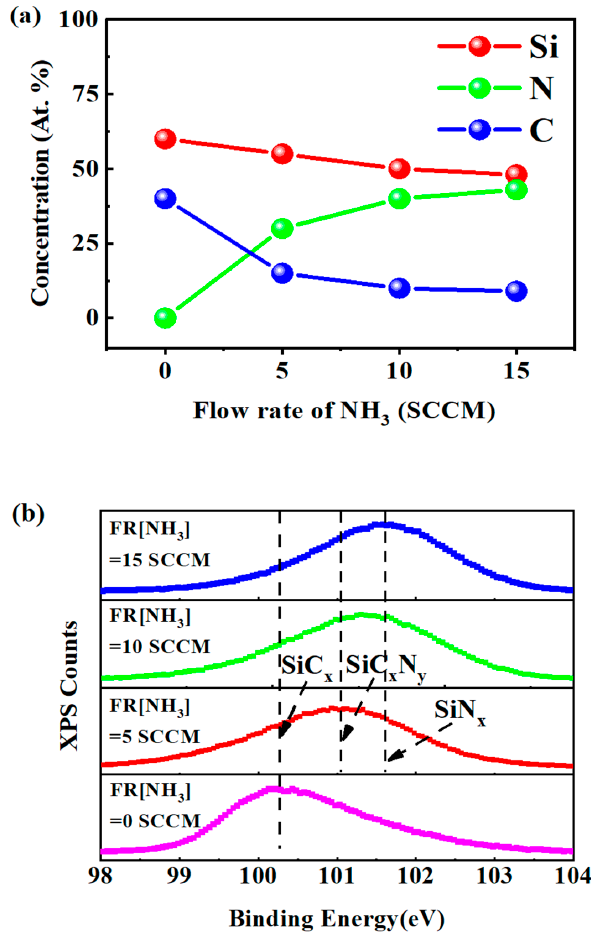
Figure 5. ( a ) The relative atomic concentration of Si, N, and C elements in a-SiC x N y :H encapsulating layers with different NH 3 flow rates. ( b ) Experimental Si 2p spectra for a-SiC x N y :H encapsulating layers fabricated at different NH 3 flow rates.